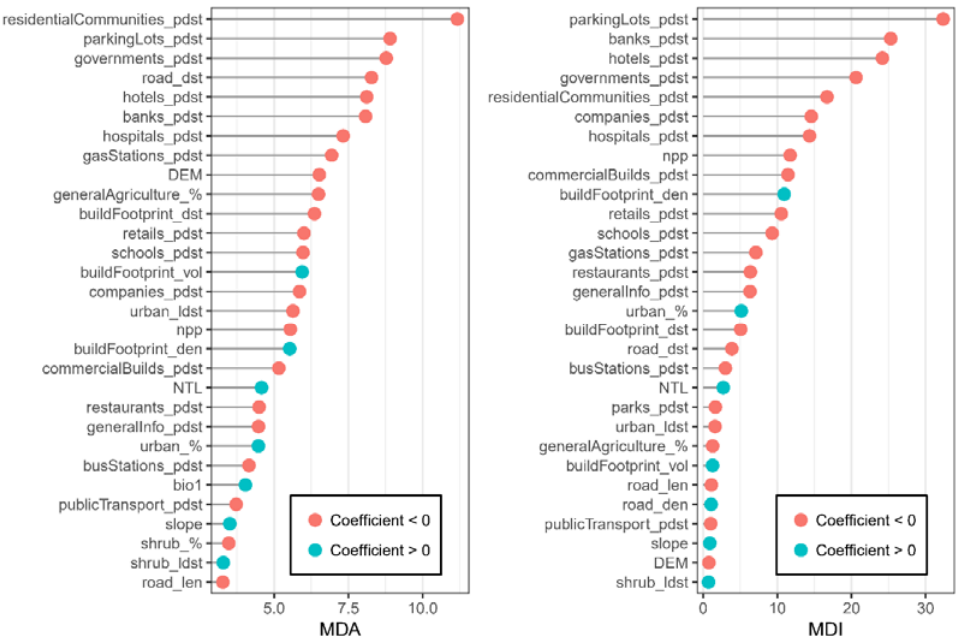
Figure 7. The thirty most important variables ranked according to their contribution to the random forest modeling, measured by Mean Decrease Accuracy (MDA) and Mean Decrease Impurity (MDI), with direction of the association between each ranked variable and the population density. Variable